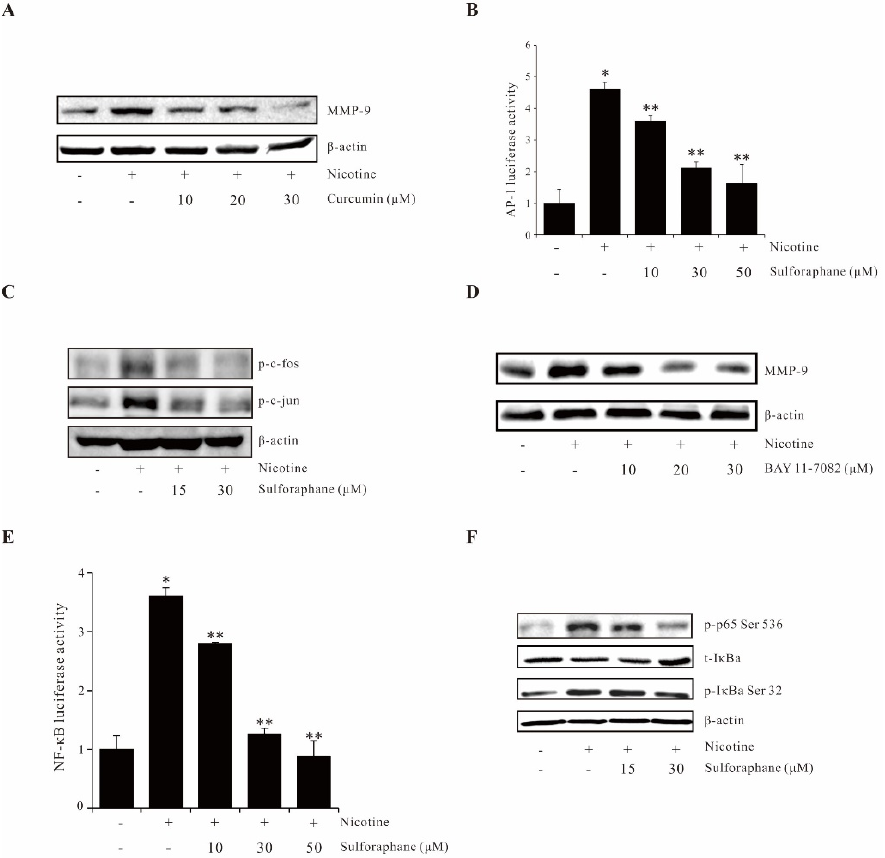
Figure 4. Sulforaphane inhibits nicotine-induced MMP-9 expression by suppressing the transcription factors of AP-1 and NF- κ B. ( A ) AGS cells were pretreated with the indicated concentration of curcumin and treated with 100 μ g/mL nicotine for 12 h, and extracted proteins were analyzed for the induction of MMP ‐ 9 expression by Western blot. ( B ) Cells were transfected with the AP ‐ 1 luciferase reporter. The luciferase activity was determined using a luminometer after incubating the cells with sulforaphane for 1 h prior to nicotine treatment for 4 h. ( C ) Cells were pretreated with sulforaphane and treated with 100 μ g/mL nicotine for 1 h; the expression of phos ‐ c ‐ fos and phos ‐ c ‐ jun were analyzed by Western blot. ( D ) Cells were pretreated with the indicated concentration of BAY11 ‐ 7082 and treated with 100 μ g/mL nicotine for 12 h, and extracted proteins were analyzed for the induction of MMP ‐ 9 expression by Western blot. ( E ) Cells were transfected with the NF ‐κ B luciferase reporter. The luciferase activity was determined using a luminometer after incubating the cells with sulforaphane for 1 h prior to nicotine treatment for 4 h. ( F ) Cells were pretreated with sulforaphane and treated with 100 μ g/mL nicotine for 1 h, the expression of phos ‐ p65 (Ser536 and phos ‐ I κ B α (Ser32) were analyzed by Western blot. The data represent the mean ± SEM from three experimental trials. * p < 0.05 in comparison with the control; ** p < 0.05 in comparison with nicotine alone.